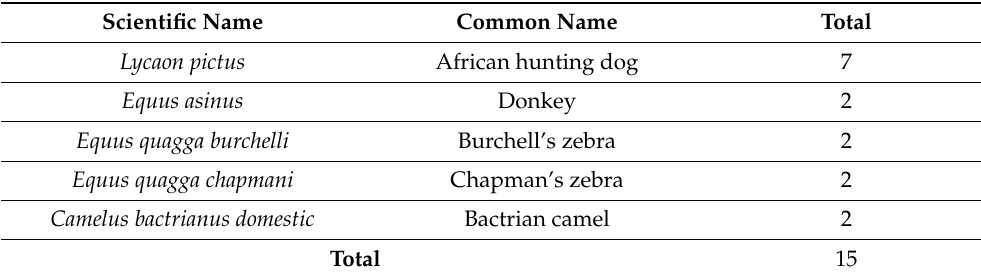
Table 3. ZSL London Zoo animals at risk of AHSV infection in 2019 [89] [H. Jenkins, personal